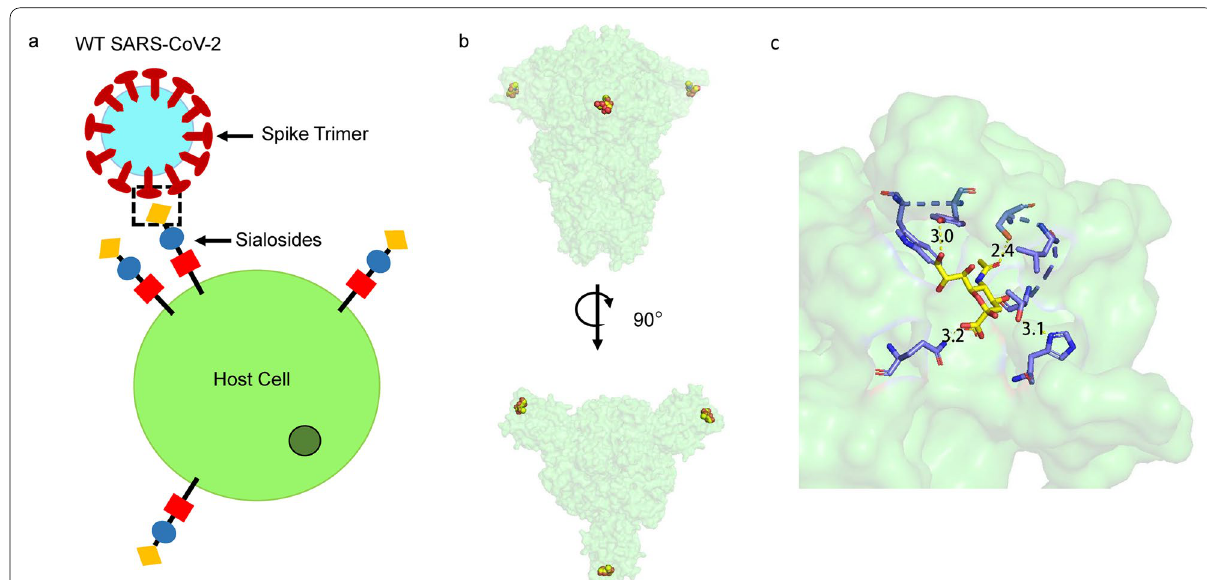
Fig. 1 The molecular mechanism of SARS-CoV-2 spike protein NTD domain interacts with Sialosides on human cell surface. a Graphical representation showing host–pathogen interactions. b Cryo-EM structure of spike protein that binds Sialosides to via its NTD, which located at the outer surface of spike protein. Sialosides (yellow) are shown in dots and the spike trimer (green) are shown in surface. c A close look to the binding site for Sialosides. The pocket is formed by H69, Y145, W152, S247 and Q183 in the spike NTD. Hydrogen bonds are show in yellow dash